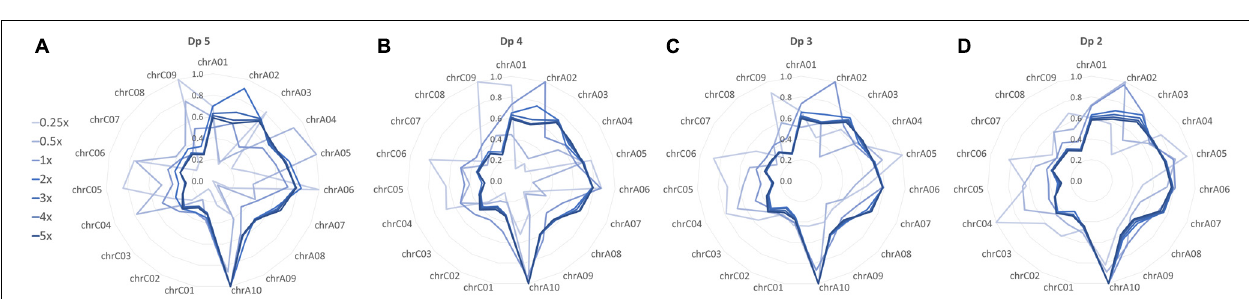
Frontiers in Plant Science |